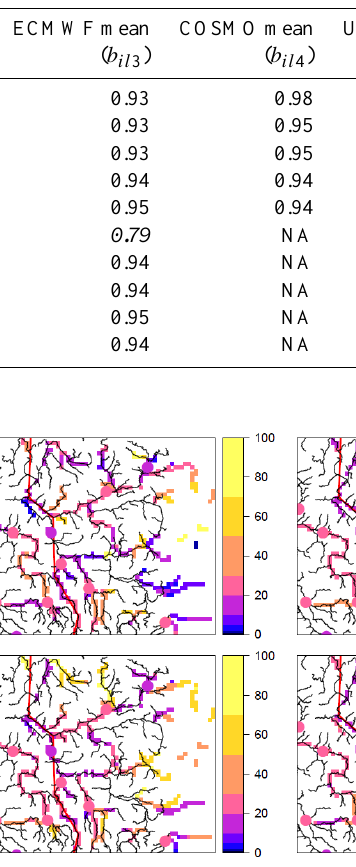
Figure 2. Predicted (dots) and simulated specific runoff (pixels) for one day lead time for a region on both sides of the German/Polish border (red line).